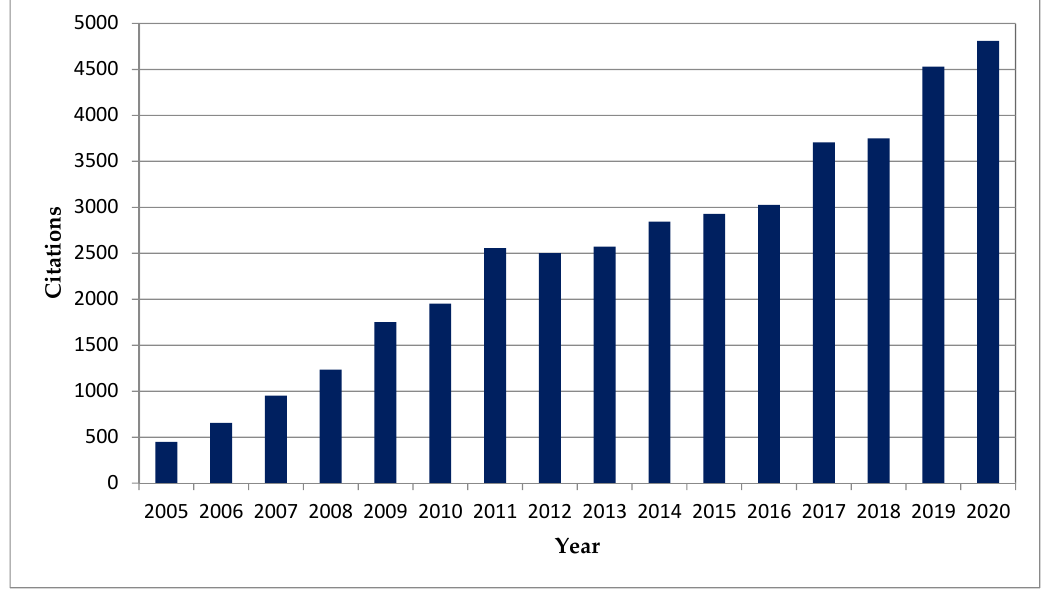
Figure 2. Number of citations of articles per year (until December 2020) related to “SOLID OXIDE FUEL CELL OPTIMIZATION”, showing the increasing research interest in this topic. Data from Scopus.